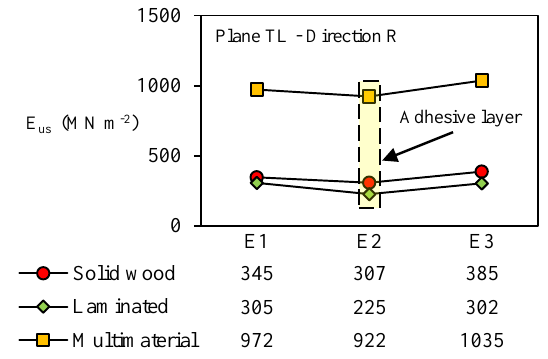
Figure 6 Dynamic Modules in Radial Direction.